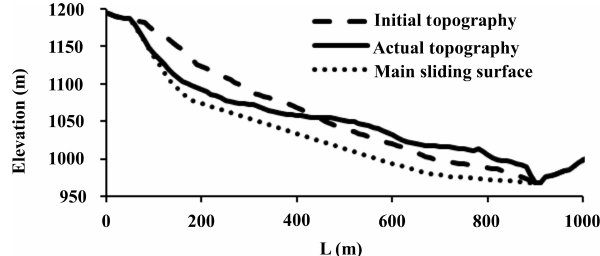
Figure 6. Initial and present BTL profiles. The larger thickness of the present profile in the downstream part of the model is a result of the relative lift-up after a trans-rotational sliding and material accumulation from the upper parts of the initial profile. Figure 7. Materialization of blocks, joints and materials for the ac-